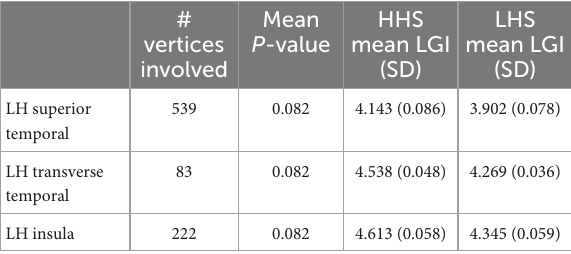
TABLE 5 HHS/LHS direct comparison for mean LGI - between-group differences (FWE